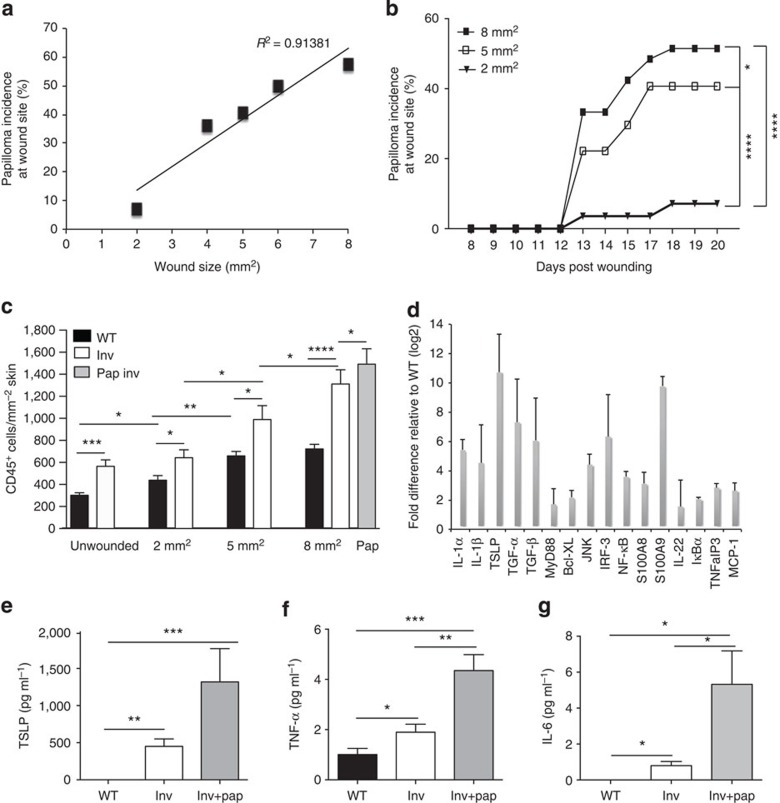
Pro-inflammatory signalling and wound-induced tumour formation in InvEE mice.(a) Correlation between wound diameter and papilloma incidence at wound site in InvEE mice 30 days post wounding (n>20 mice per condition). (b) Incidence of tumours in InvEE mice in 2 mm2 (n=28 mice), 5 mm2 (n=27 mice) or 8 mm2 (n=33 mice) wounds (*0.01<P<0.05; ****P<0.0001; one-way analysis of variance (ANOVA)). (c) Quantification of CD45+ leukocytes in different sized wounds at time of wound closure (n≥4 mice per condition, at least three microscopic fields were quantified per mouse; *0.01<P<0.05, **0.01<P<0.001, ***0.0001<P<0.001, ****P<0.0001; two-way ANOVA). (d) Quantitative PCR normalized to glyceraldehyde 3-phosphate dehydrogenase of NF-κB target gene mRNAs in 8-week-old InvEE epidermis relative to transgene negative littermates (log 2-fold upregulation relative to WT; n=3 mice per condition). Data are means±s.d. of biological and technical triplicates (P<0.0001 for each individual gene product; unpaired t-test). (e–g) Serum levels of TSLP (e), TNF-α (f) and IL-6 (g) in control, tumour-free and tumour-bearing InvEE mice, assessed by ELISA (n=4 mice per condition; *0.01<P<0.05, **0.01<P<0.001, ***0.0001<P<0.001; unpaired t-test). Data are means±s.e.m.; pap: papilloma.